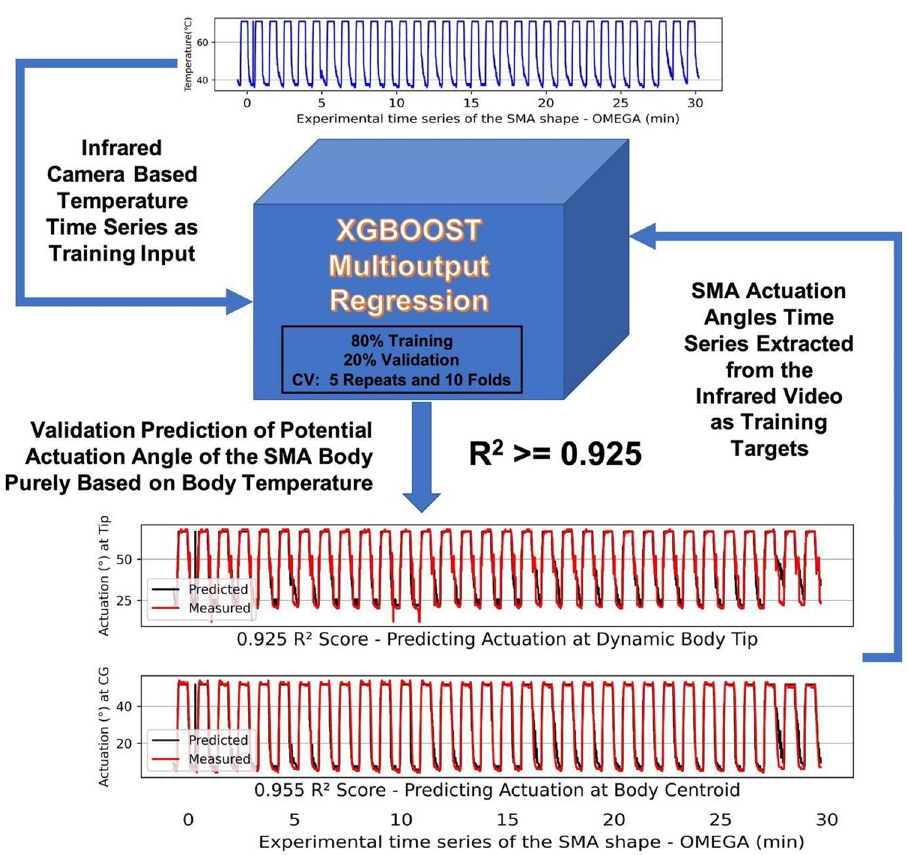
Fig 5. Results of prediction for the aim A. A XGBoost regression model was the best model to predict possible actuation angles (at the BC and at the Tip) with a R 2 score in a range of 0.925–0.974, while taking the dynamic maximum body temperature as the only input to the model, achieving a mean accuracy of 95%. An example of prediction results is depicted in the figure using an Omega shaped SMA.